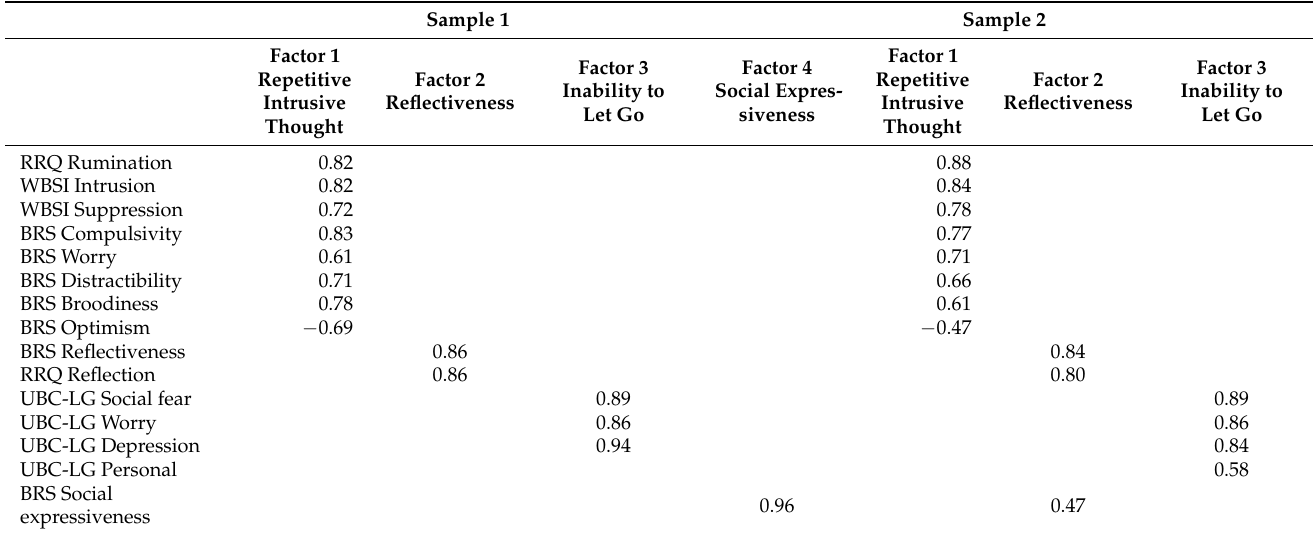
Table 1. Results from factor analysis of the different rumination-related scales in both samples; principal component analysis with oblimin rotation; pattern matrix is